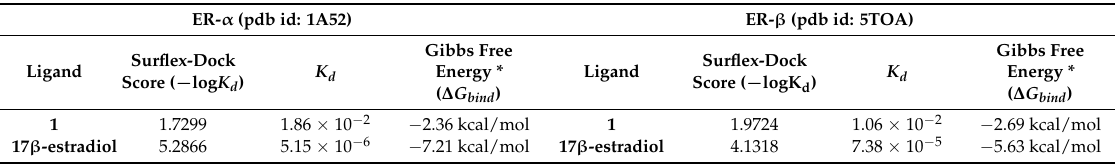
Table 2. Calculated Gibbs free binding energy for 1 :ER versus the 17 β -estradiol:ER